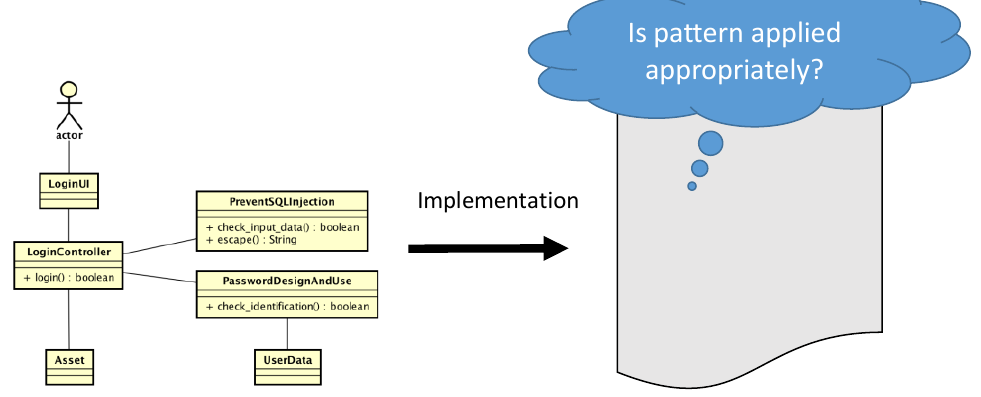
Figure 5. Implementation of the “login” portion of a class diagram for payment processing.